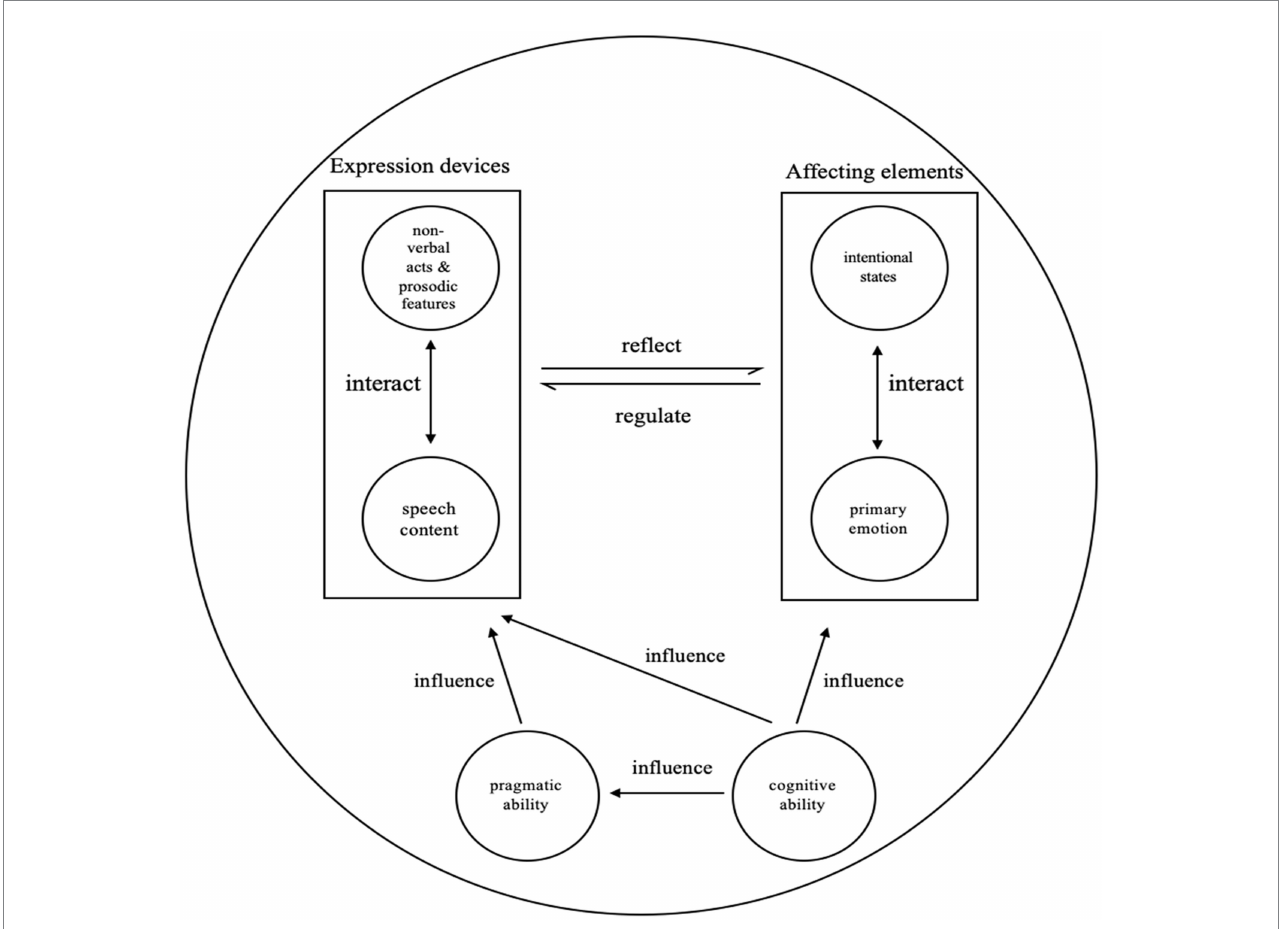
FIGURE 5 The interactive mechanism of performing the